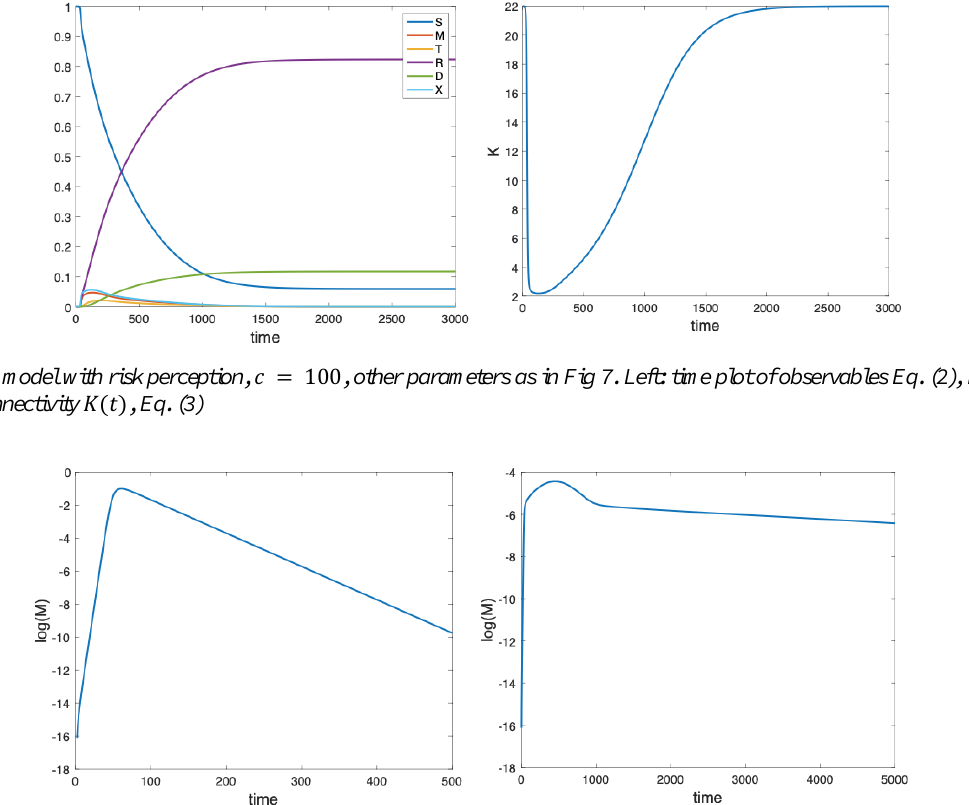
Figure 9. Plots in a log-lin scale. (left) fraction of M people without risk perception ( 𝑐 = 0 ); (right) fraction of M people with extreme risk perception 𝑐 = 1000 , other parameters as in Fig 7